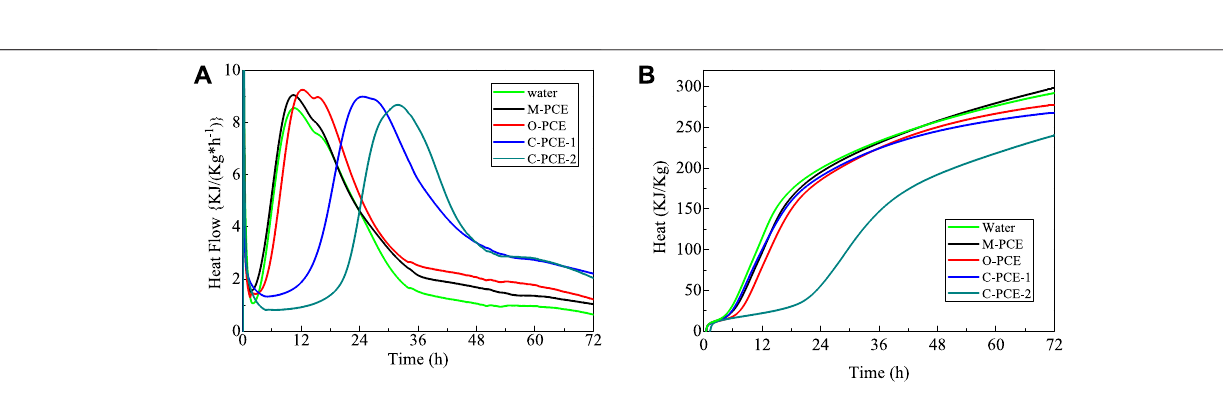
FIGURE 11 | The adsorption mechanisms of polycarboxylate: (A) O-PCE and C-PCEs and (B) M-PCE.